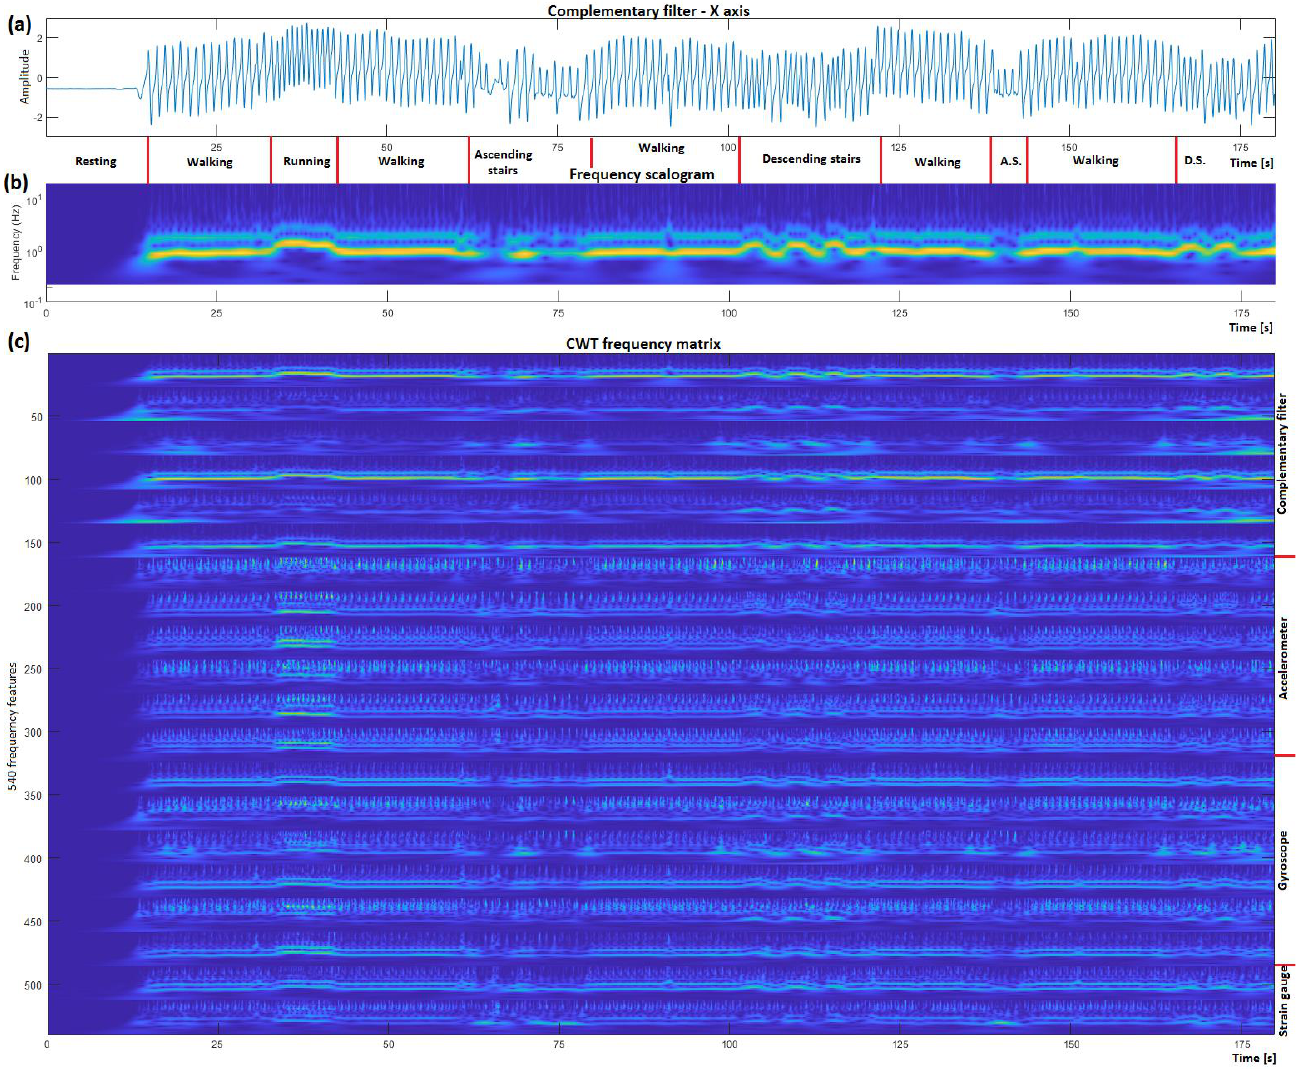
Figure 7. Auto encoder structure. 2.3.3. Machine Learning Algorithms In this study, ML algorithms were used for classification of the recorded and pro- cessed data (Figures 5 and 6) into five pre-specified gait activities. The data label information was used as a ‘target’ for trai ning the ML algorithm (a target indicating the desired output of the algorithm), so that when the trained ML